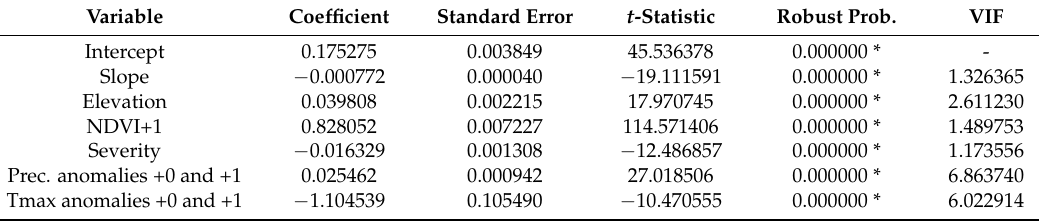
Table 5. Frequency Ordinary Least Squares (OLS) results for Pinus halepensis in the 95% confidence